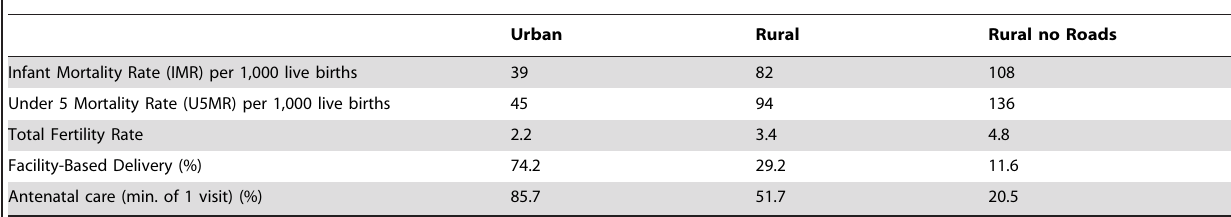
Table 1. Maternal Health Indicators 1 .